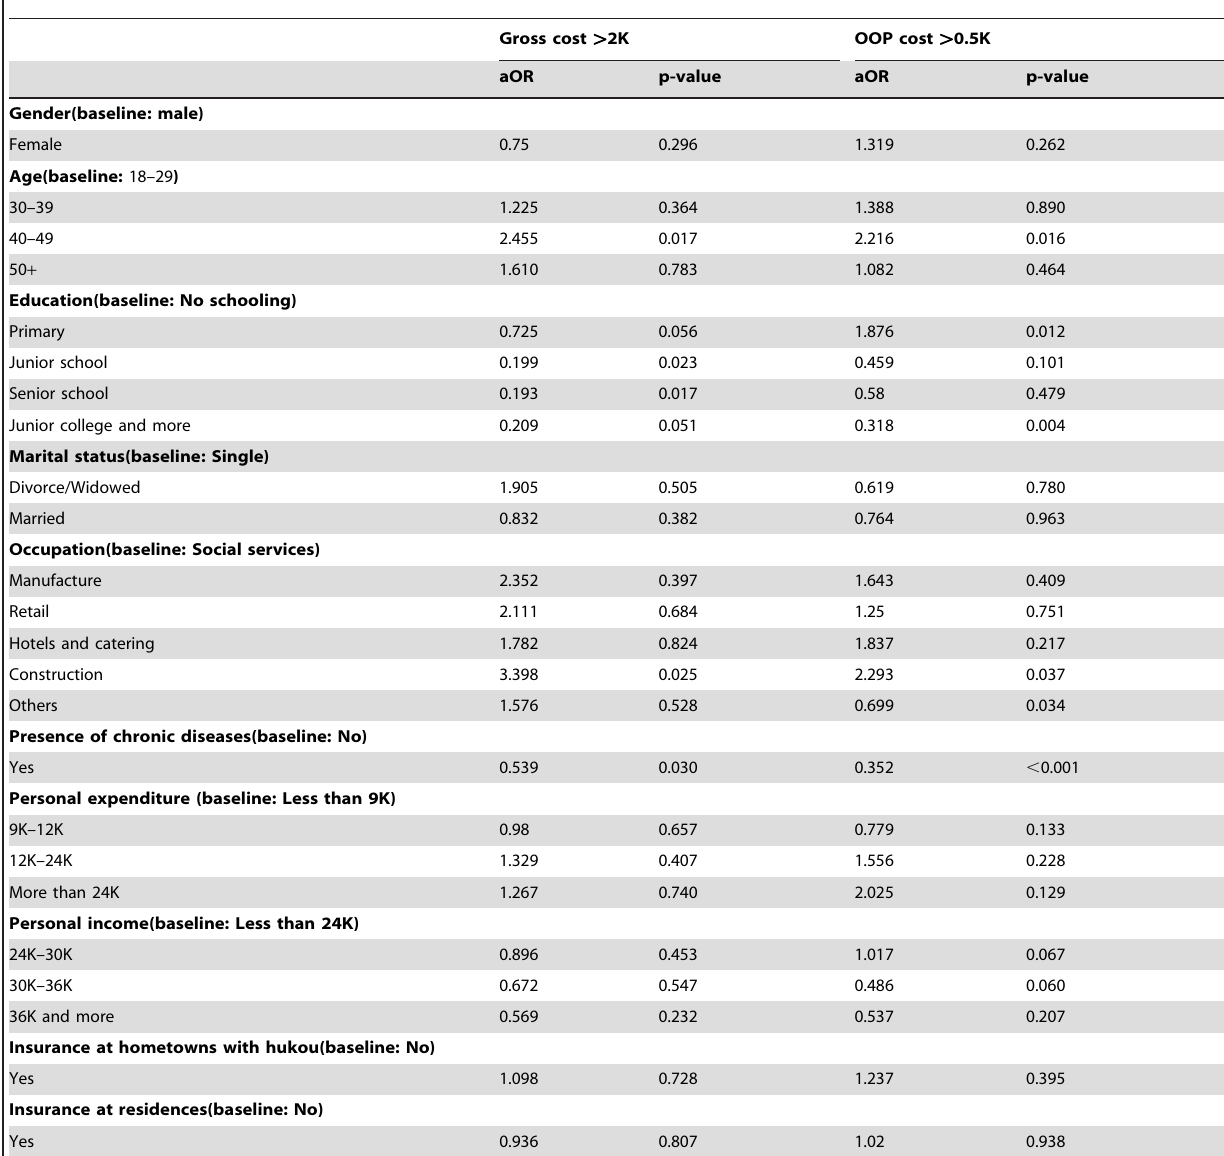
Table 4. Multivariate logistic regression analysis of gross and OOP